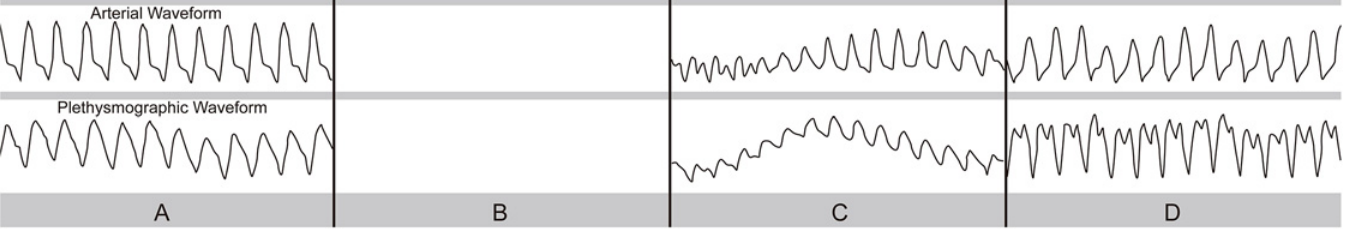
Fig 2. The arterial waveform and POP during different stages of CPR A. The arterial waveform and POP during spontaneous circulation at baseline; B. Both the arterial waveform and POP disappeared during VF; C. The arterial waveform and POP during low quality resuscitation; D. The arterial waveform and POP during high quality resuscitation.